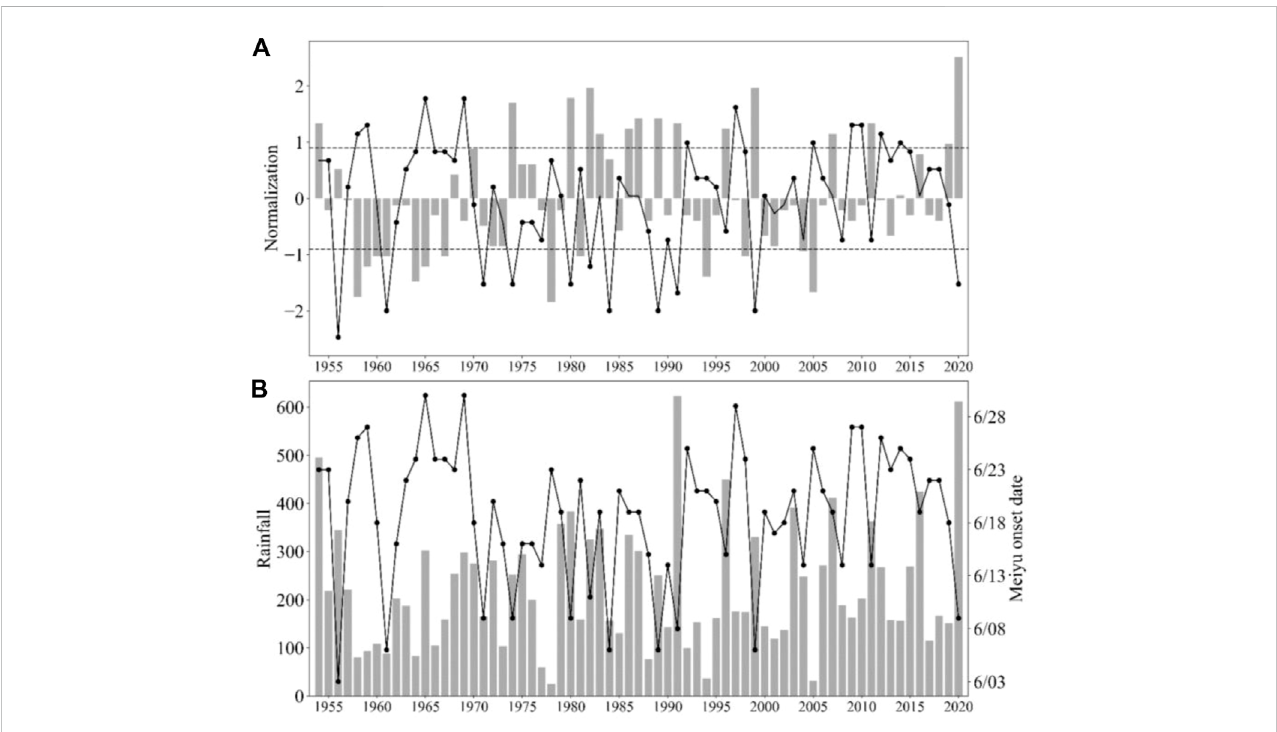
FIGURE 1 (A) Standardized time series of the onset date of Meiyu and the duration of Meiyu (the dotted line represents 0.9 times the standard deviation) in Jiangsu from 1954 to 2020 (B) Rainfall during Meiyu period and the onset date of Meiyu (The bar represents the duration of Meiyu and rainfall during Meiyu, and the broken line represents the onset date of